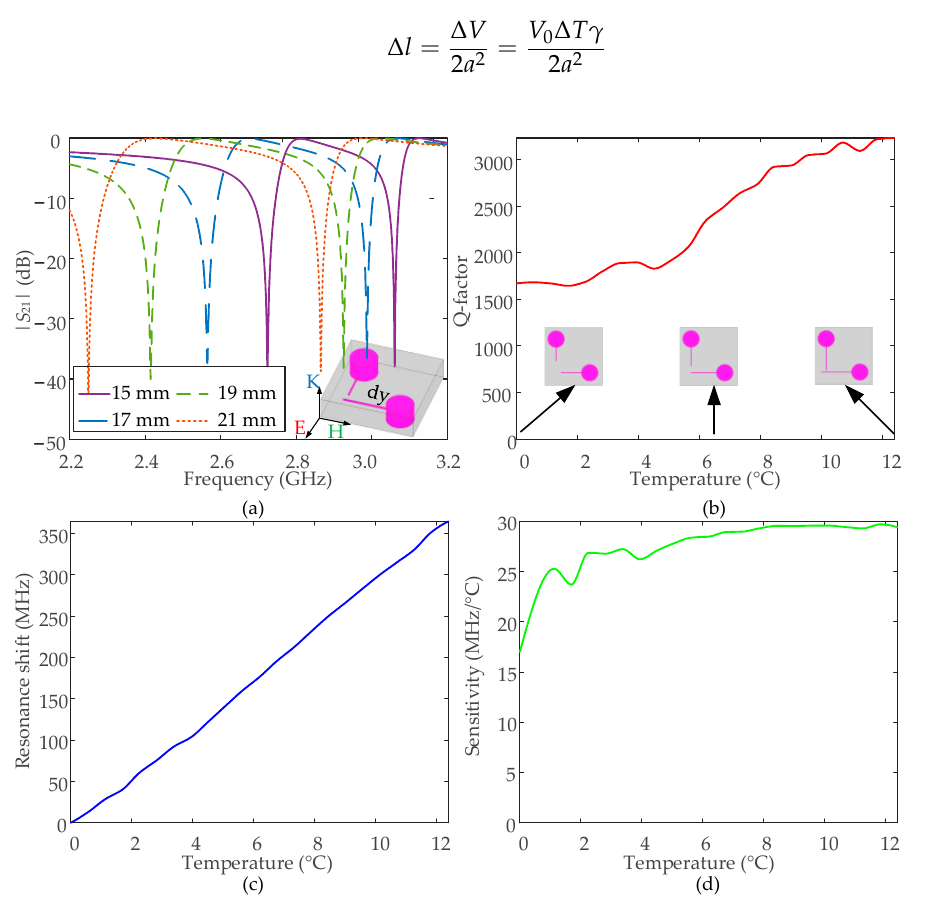
Figure 2. ( a ) The simulated transmission curves of the Hg-EIT-like liquid metamaterial unit under different parameter Hg bar lengths, and ( b ) the calculated Q-factor, ( c ) resonant frequency shift, and ( d ) temperature sensing sensitivity as a function of changes in temperature.